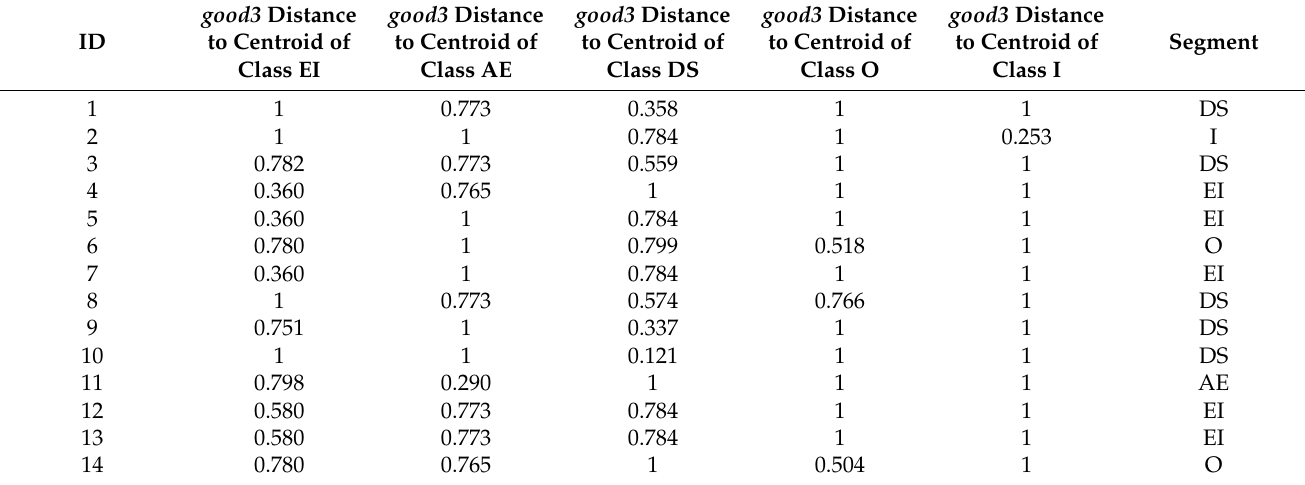
Table A1. The good3 distance calculated between points representing sample respondents and every centroid of the segments: EI, AE, DS, O and